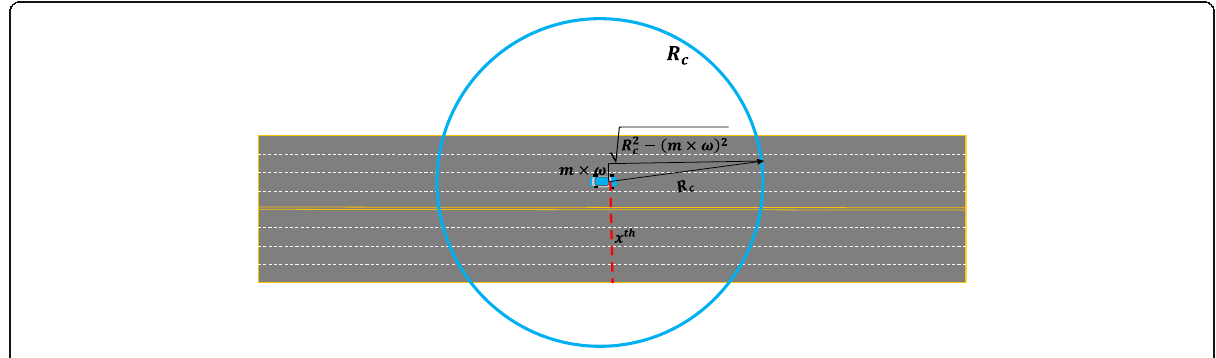
Fig. 21 Number of vehicles in the communication range calculation for a vehicle in x th lane